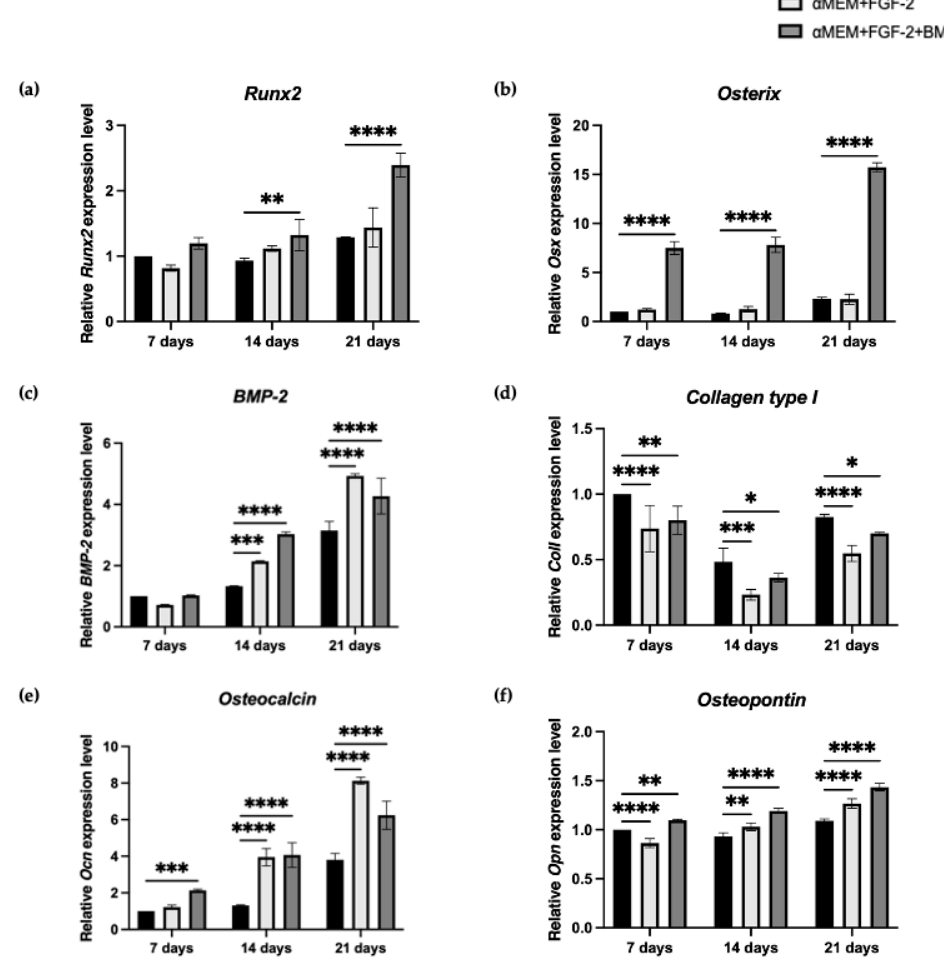
Figure 9. Relative expression of the early osteogenic differentiation gene markers ( a ) Runx2 , ( b ) osterix (Osx), ( c ) BMP-2, and ( d ) collagen type I (ColI) and late osteogenic gene markers ( e ) osteocalcin (Ocn) and ( f ) osteopontin (Opn), analyzed with real-time PCR in ovine BM-MSCs grown on an nHAP-coated PCL/HAP/β -TCP scaffold with or without FGF-2 alone or with FGF-2 and BMP-2 for 21 days. Three independent experiments were each performed in duplicate. * p < 0.05, ** p < 0.005, *** p < 0.001, **** p < 0.0001.